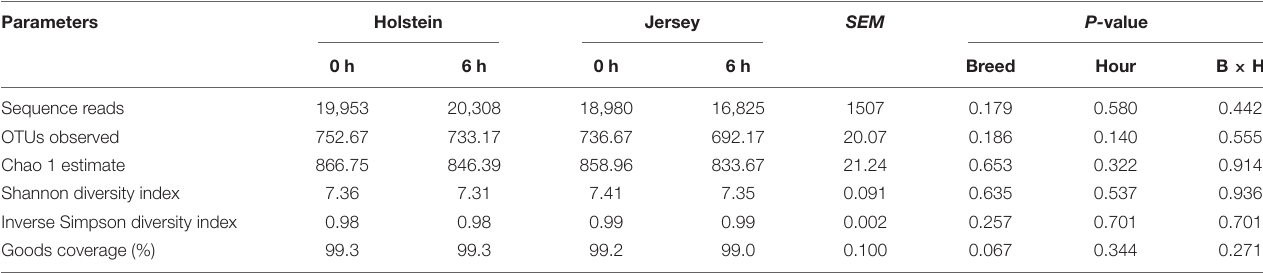
TABLE 4 | Sequence reads and alpha diversity measurements of rumen microbiota of Holstein and Jersey steers.